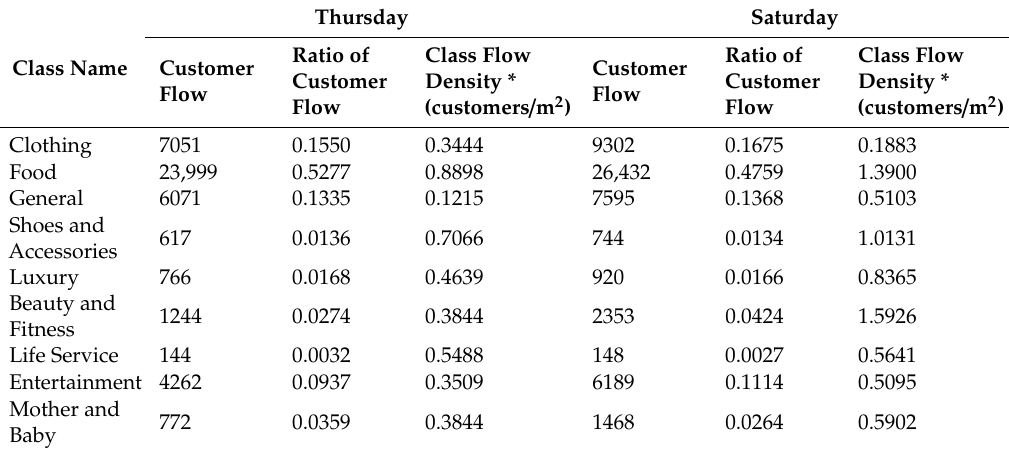
Table 3. Statistics of customer flows for store classes in